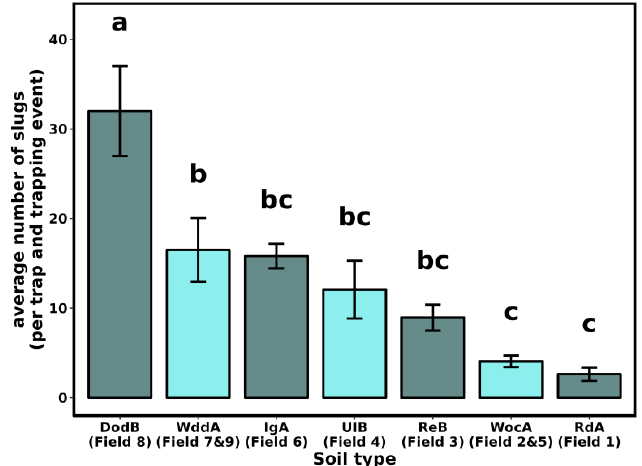
Figure 2. Average number of slugs collected per trap (4 traps of 1 m 2 ) and per trapping event (4) by